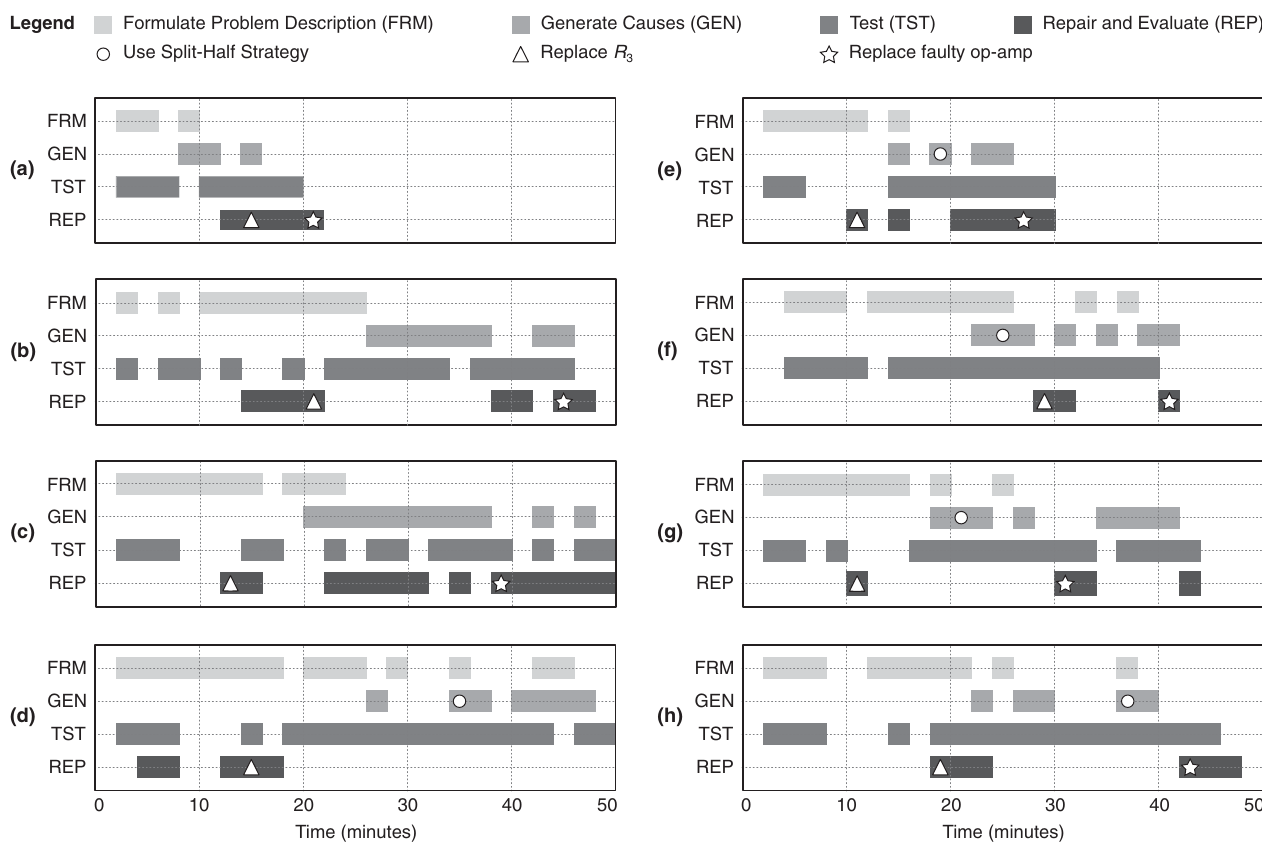
FIG. 6. Cognitive troubleshooting task coding results. Codes were applied to discrete 2-min time intervals. Colored bands indicate the times during which each pair engaged in the following tasks: formulate problem description (FRM, light gray); generate causes (GEN, medium-light gray); test (TST, medium-dark gray); and repair and evaluate (REP, darkest gray). White triangles and stars in the dark gray REP bands indicate times at which students replaced the 100 Ω resistor and faulty op-amp, respectively. White circles in the medium-light GEN bands indicate times at which students employed the split-half strategy. There are no codes in the first 2 min of the activity because the interviewer was giving verbal instructions during these times. Subplots (a) – (h) correspond to pairs A through